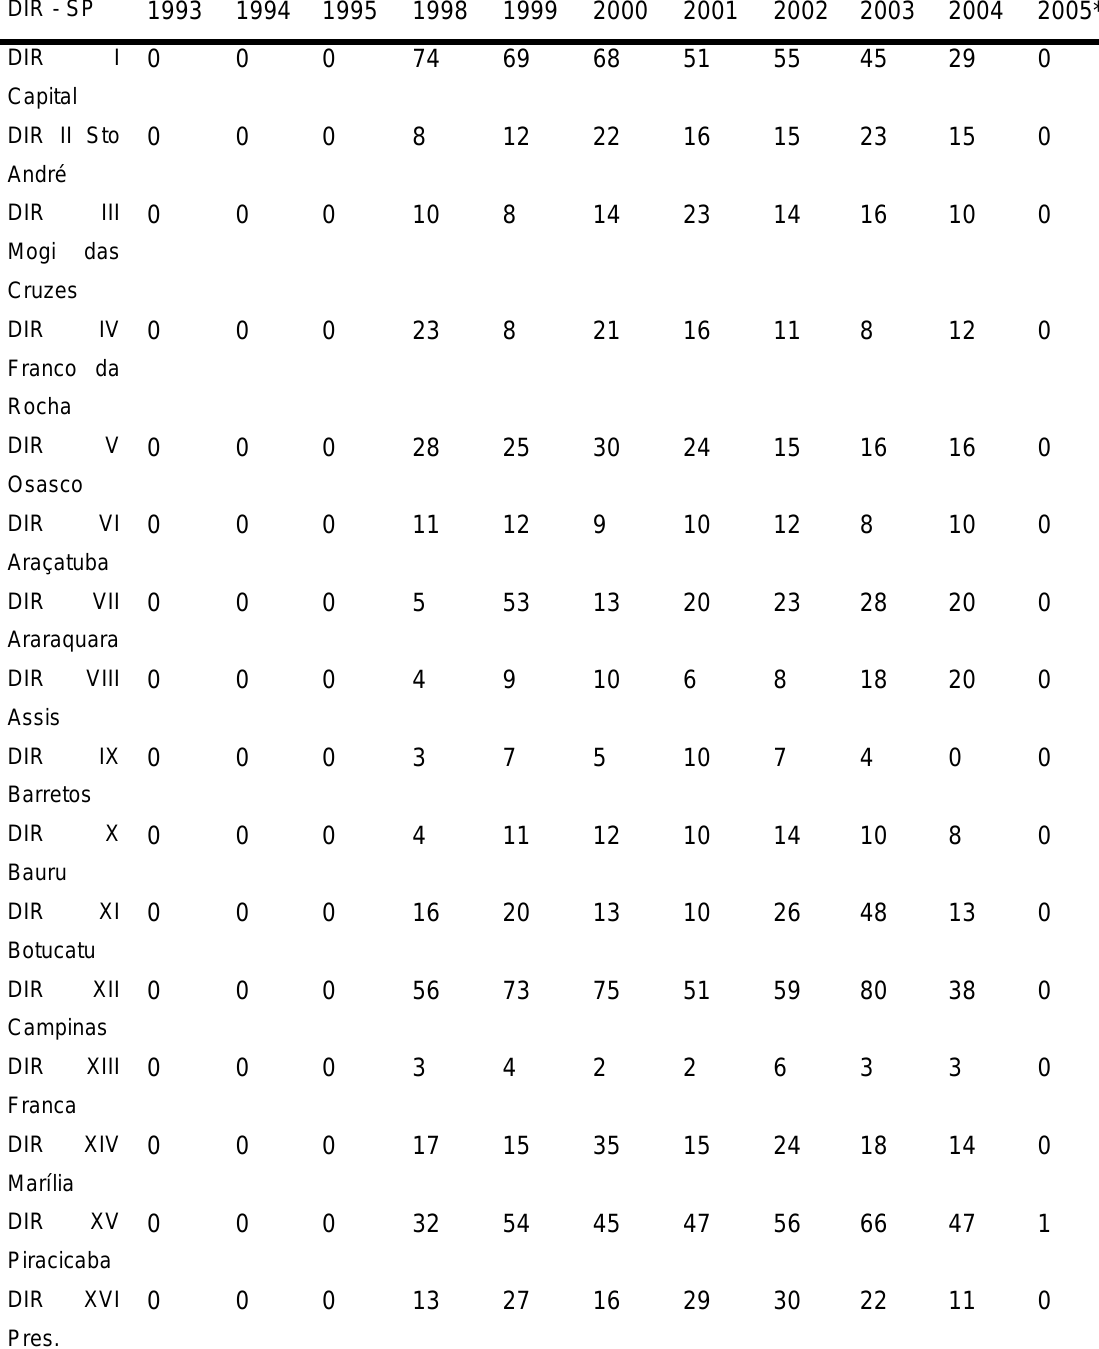
Table 2. Cases of Cutaneous Leishmaniasis in the state of São Paulo according to the city and year of